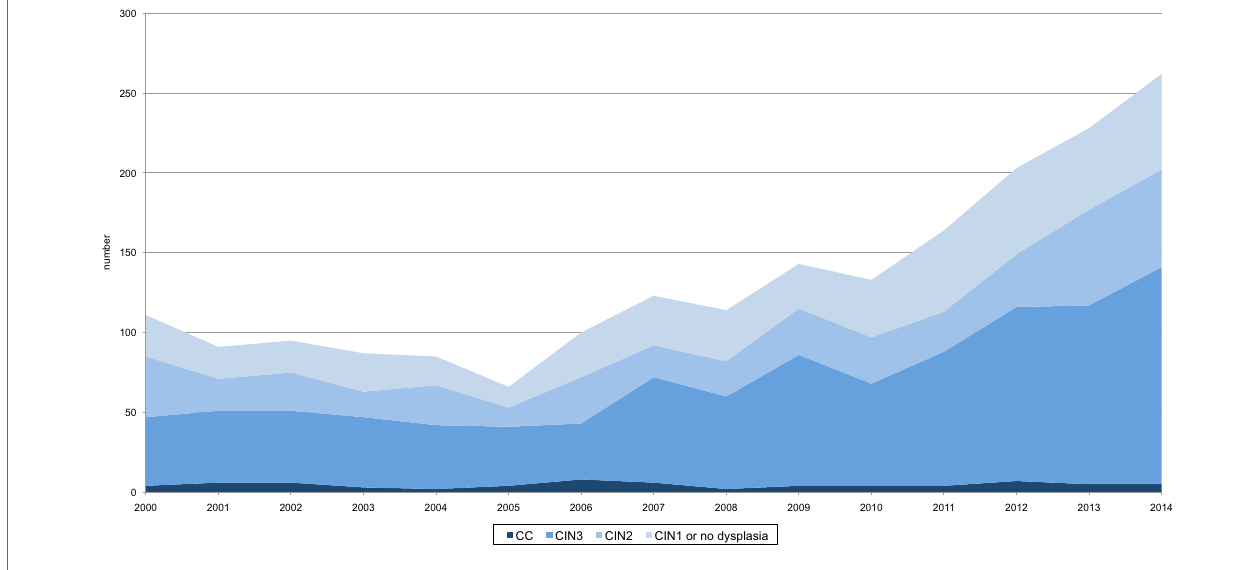
FigUre 2 | Number and proportions of dysplastic findings and cervical cancer (CC) diagnosed by conization in Central Switzerland, 2000–2014. There is a significant increase of conizations ( n = 2,005) as well as CIN3 and CIN2 diagnosed by conization ( p -value < 0.001, respectively). CC shows a stable